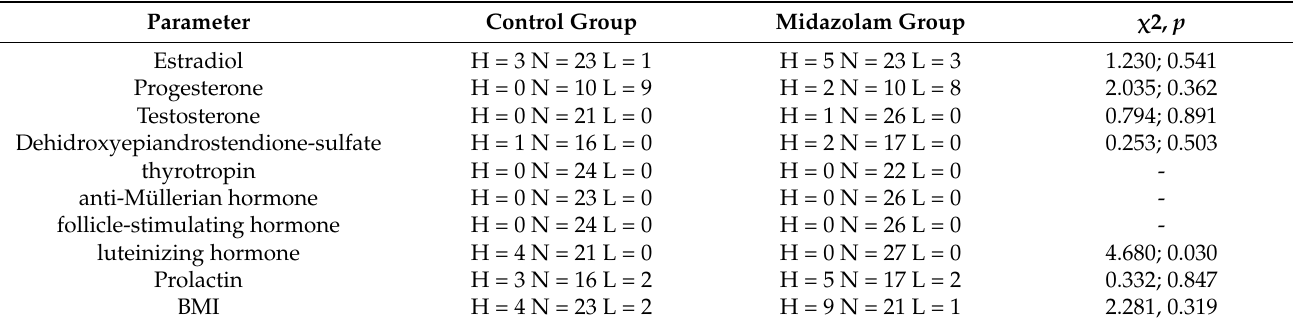
Table 1. Patients’ hormonal status.